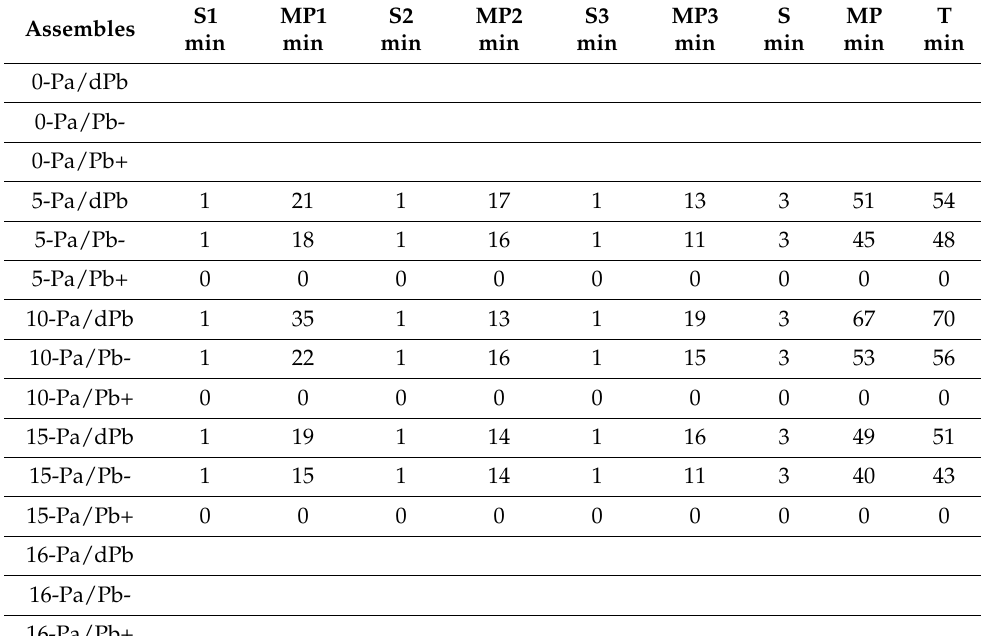
The working times required for the adjustment of the complementary framework to the assembly surface of the Pa framework that are presented in Table 3.